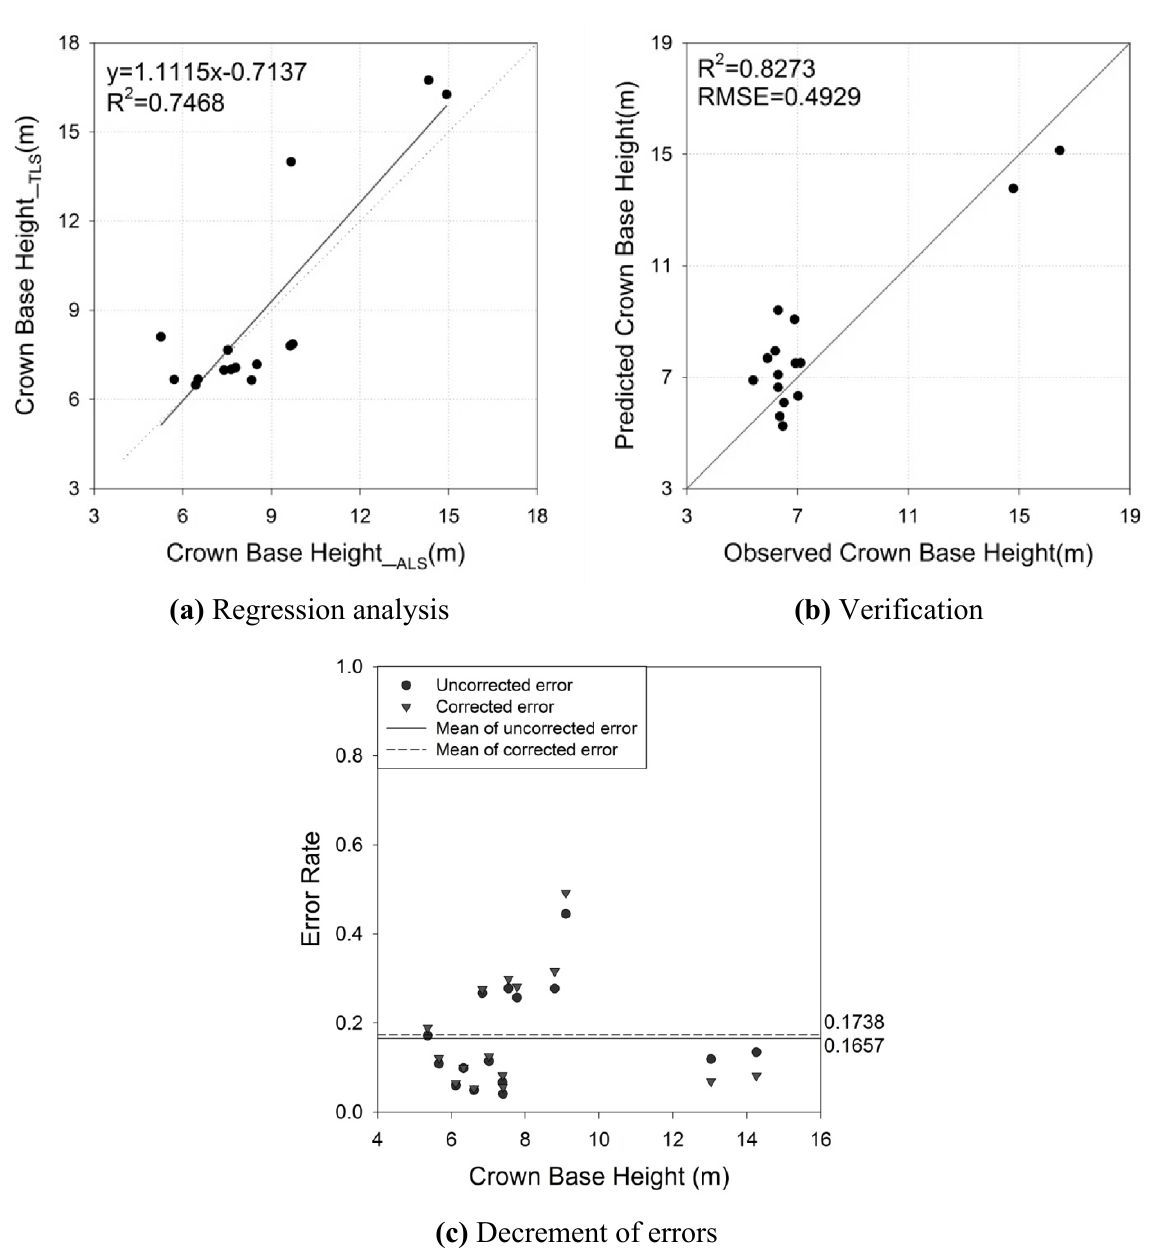
Figure 7. Reduction of CBH-estimate errors through the regression